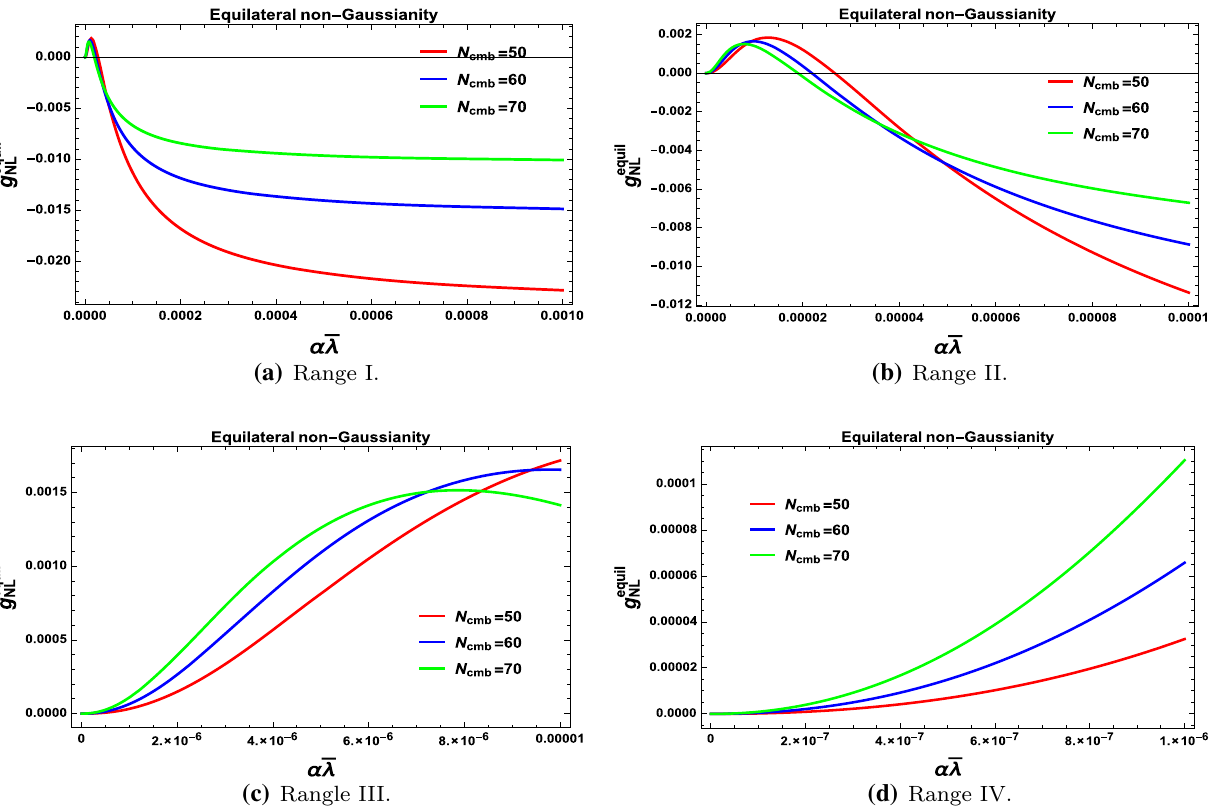
Fig. 22 Representative diagram for equilateral non-Gaussian three point amplitude vs. product of the parameters α ¯ λ in four different regions for = 50 ( red ), N = 60 ( blue ) and N = 70 ( green N cmb cmb cmb